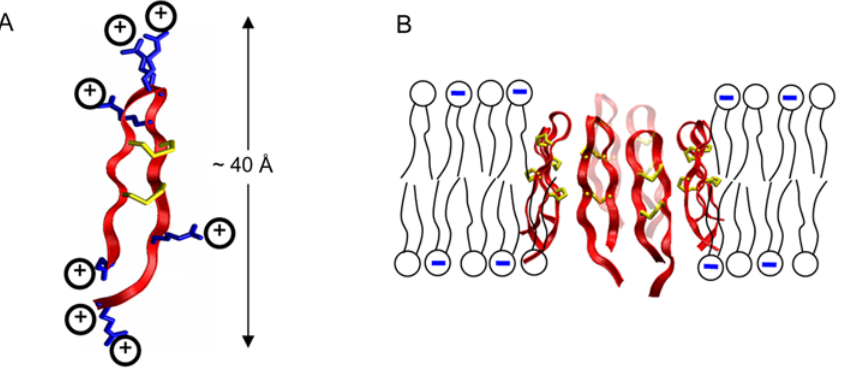
Figure 1. Pore-forming protegrins. (A) A single protegrin peptide; note the abundance of positive charges due to arginine side chains (shown in blue). Cysteine-cysteine disulfide bonds are shown in yellow. (B) Eight protegrin peptides aggregate to form a membrane-spanning pore.